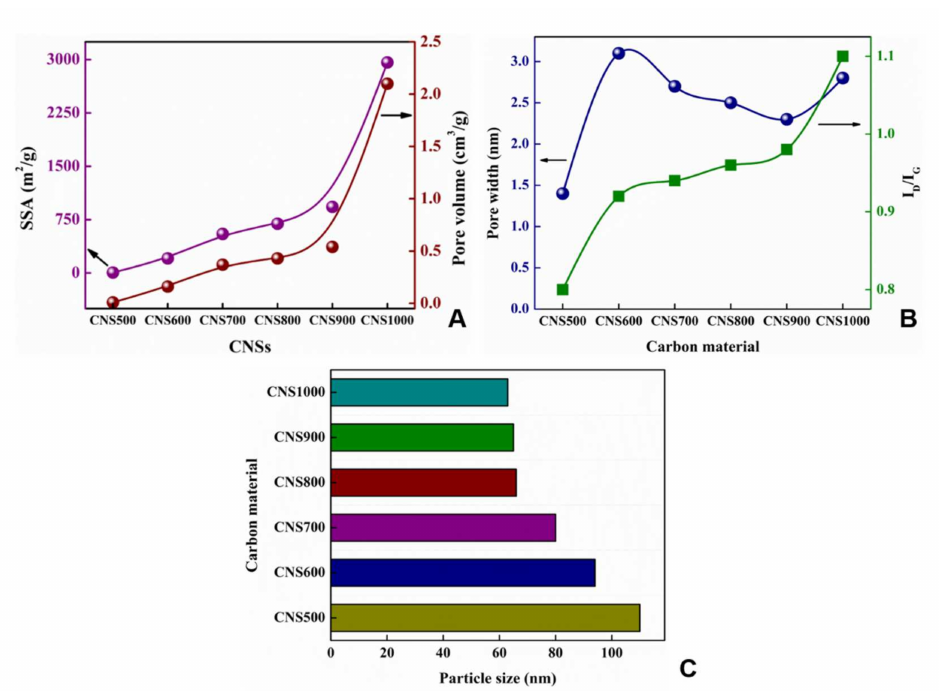
Figure 3. BET specific surface area and pore volume ( A ), pore width and I D /I G ( B ), and particle sizes of different carbon materials ( C